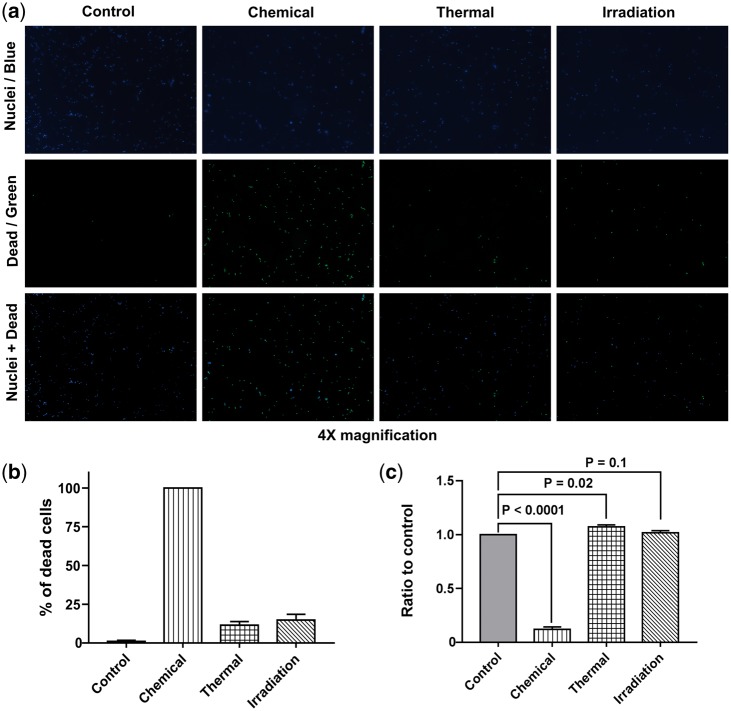
Results of MSC viability assays with BCM. (a) Representative images of MSC fluorescent microscopy after exposure to BCM for 72 h with (b) the calculated percentage of dead cells. All pictures were taken at 4× magnification. (c) MTT assay: ratio of MSC viability normalized to control after 72 h culture with different types of BCM